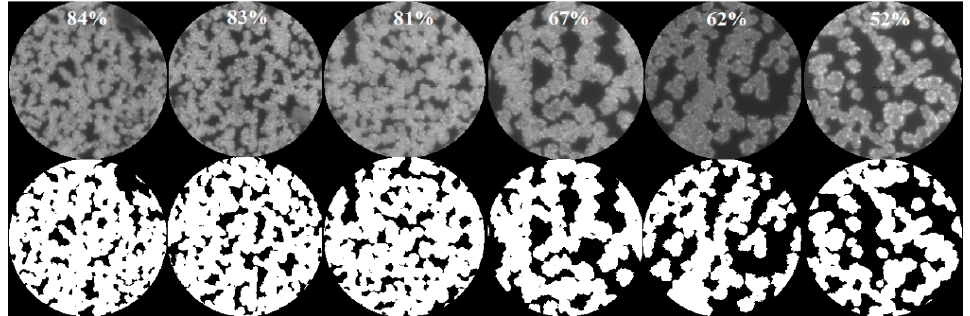
Figure 7. Measured and binarized images of substrate A for duty cycle calculation with 40 μ m laser spots.